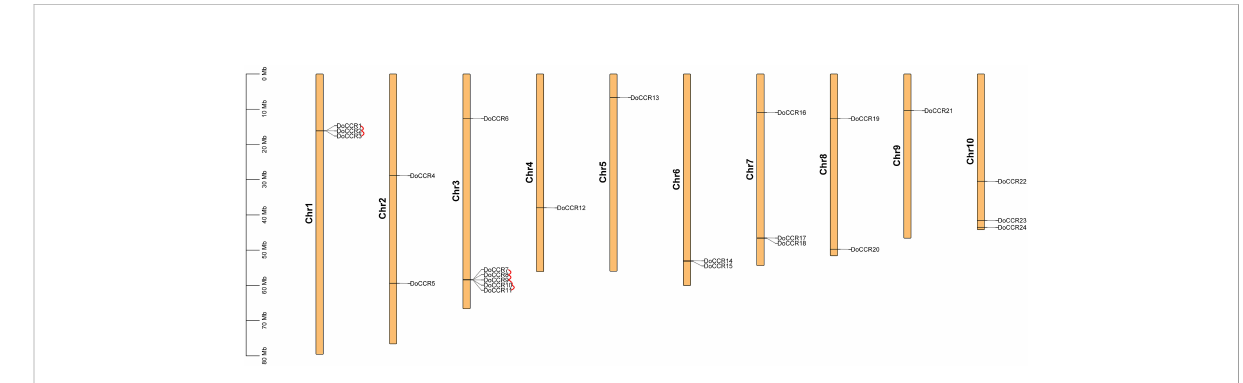
FIGURE 1 Chromosomal locations of CCR genes in D. odorifera . Each vertical bar indicates one chromosome. The chromosome number is shown at the left of each chromosome. Chromosomal locations of DoCCRs were mapped based on the D. odorifera genome. Red lines indicate tandem gene